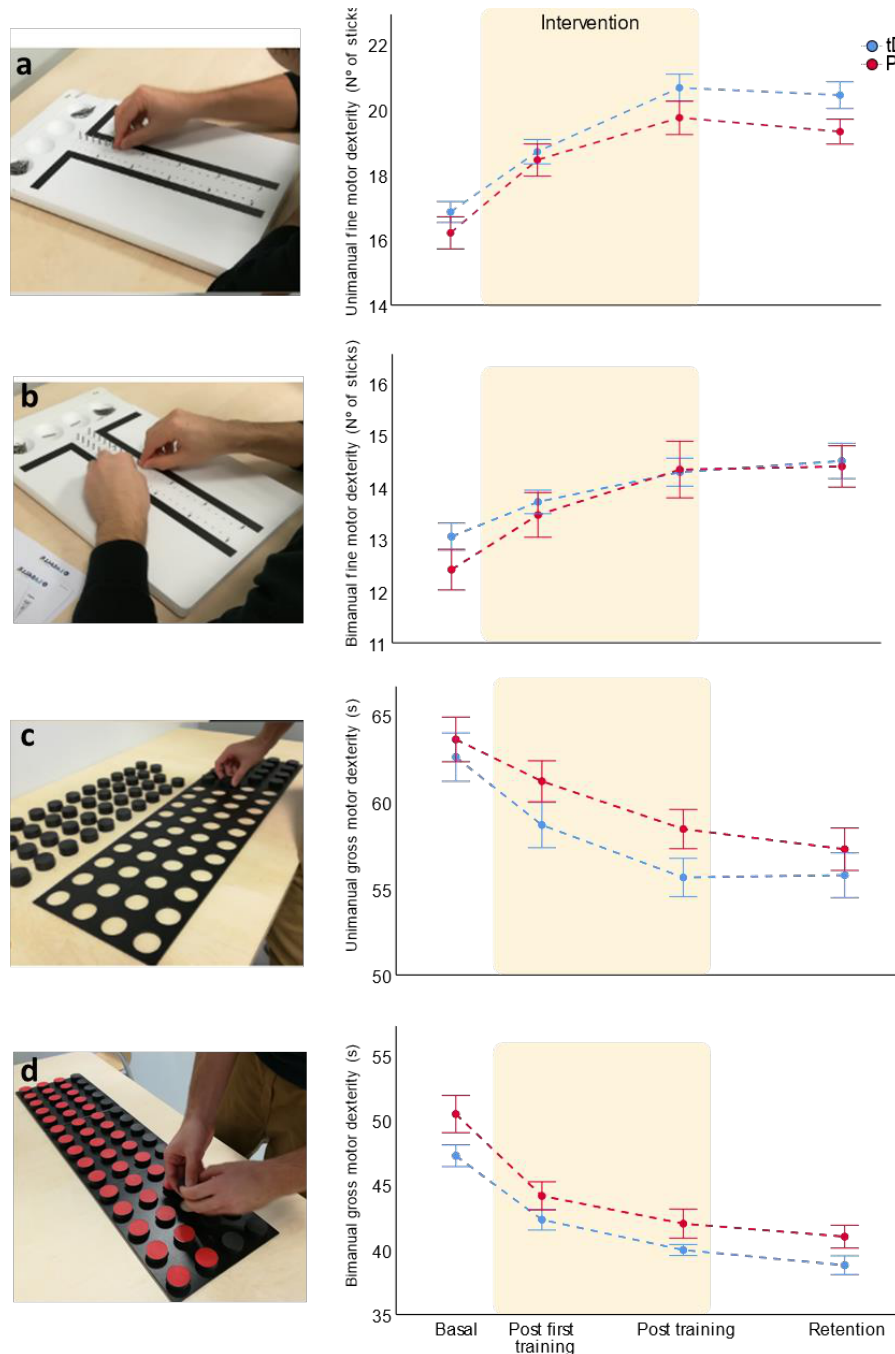
Figure 4. Bi-RP-tDCS effects on motor learning training. This figure shows the temporal evolution of the different motor dexterity variables assessed over days: ( a ) unimanual fine motor dexterity; ( b ) bimanual fine motor dexterity; ( c ) unimanual gross motor dexterity; and ( d ) bimanual gross motor dexterity. The data representation shows mean ±